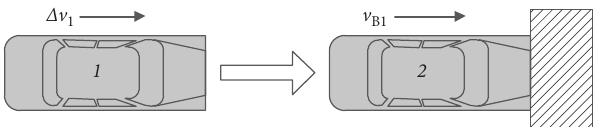
Figure 24: Velocity variation and equivalent barrier